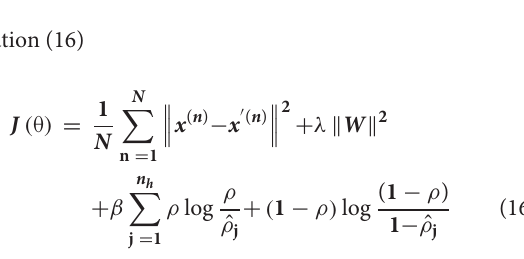
Here, dimensionality of input and hidden layer is given by n x and n h while sigm ( x ) = 1 is the logistic sigmoid 1 + e − x